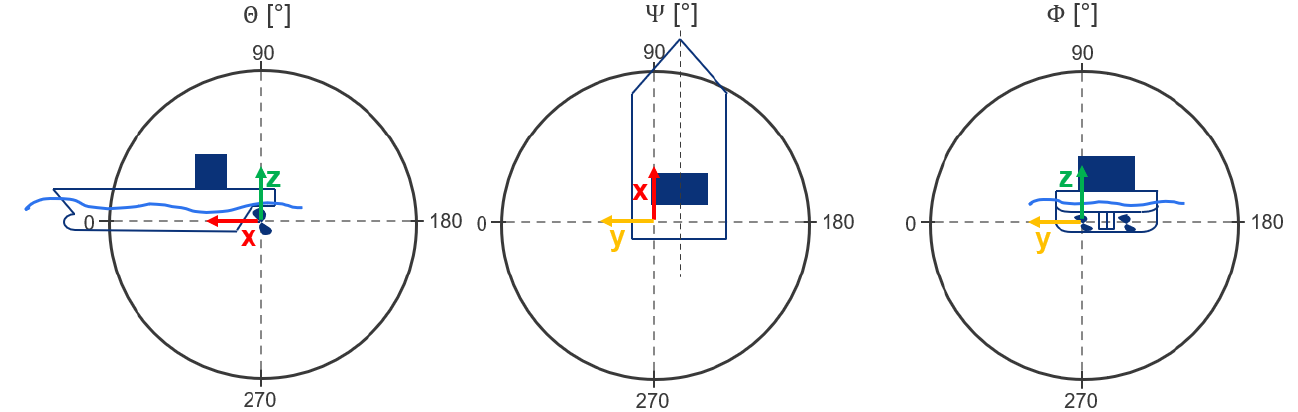
Figure 25. Definition of the spherical coordinate system for the directivity investigation.